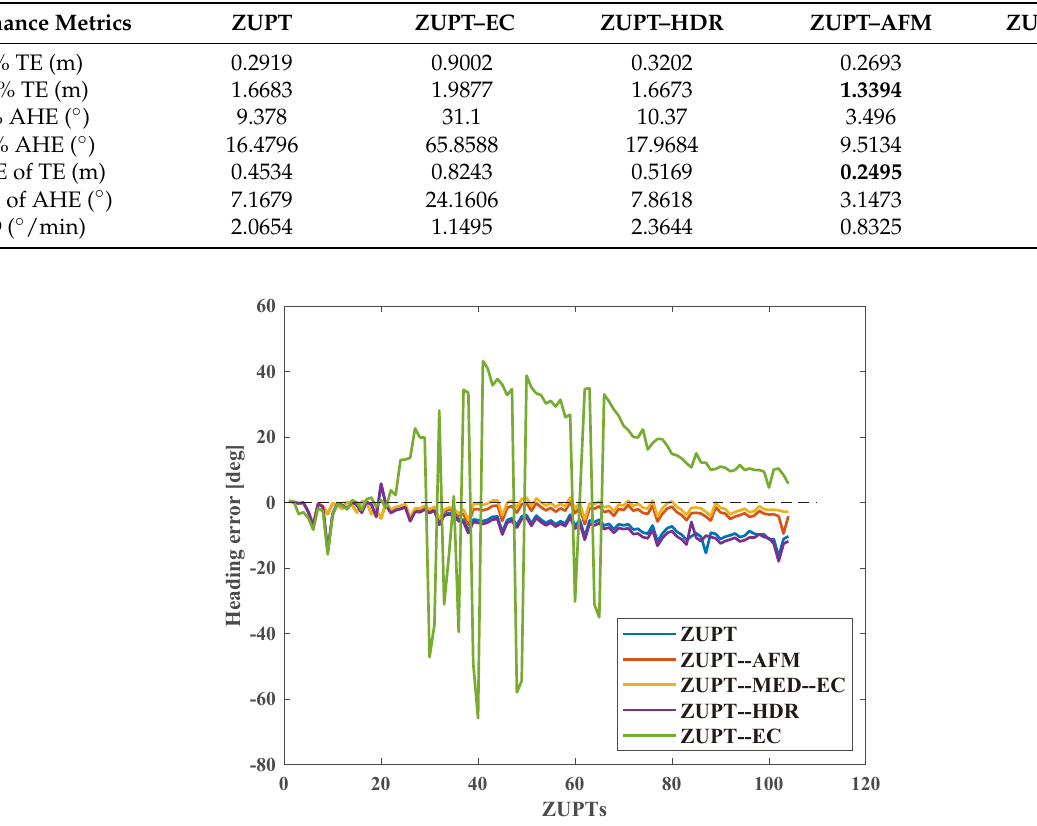
Figure 6. Heading errors of different